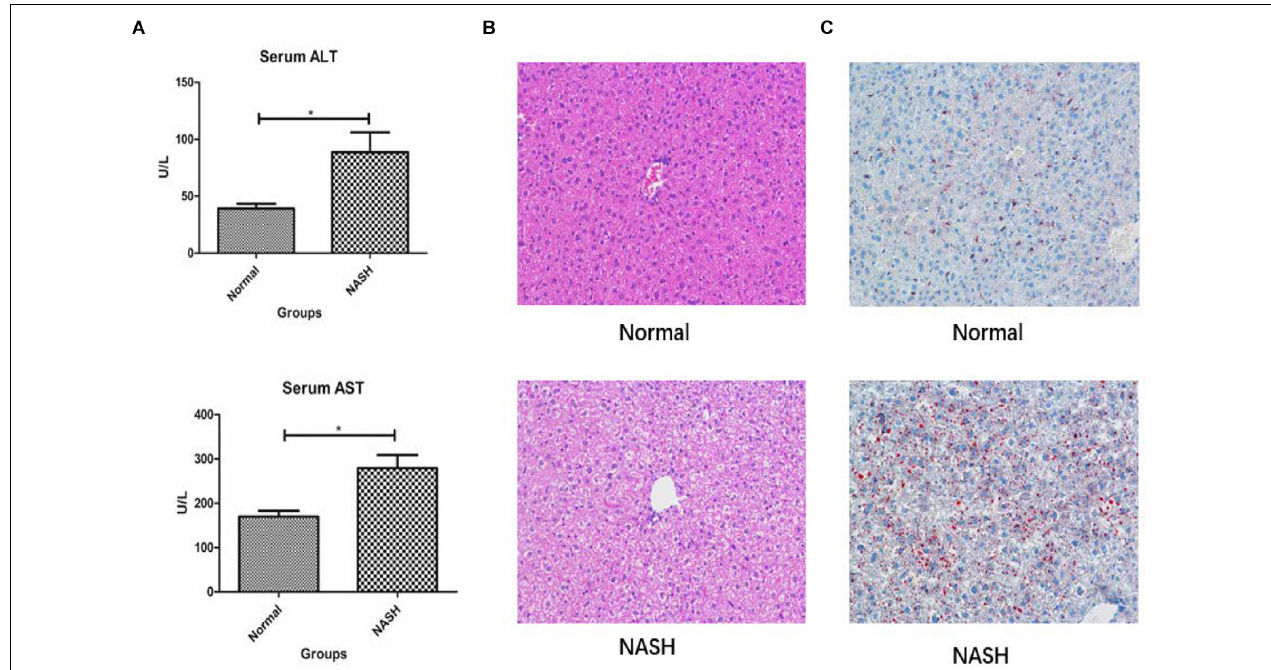
FIGURE 6 | Liver biochemical analysis, HE and Red 0 staining. (A) Displays serum ALT and AST levels in Normal and NASH groups. (B) Displays HE staining of liver tissue. (C) Shows Red 0 staining of liver tissue * p < 0.05.